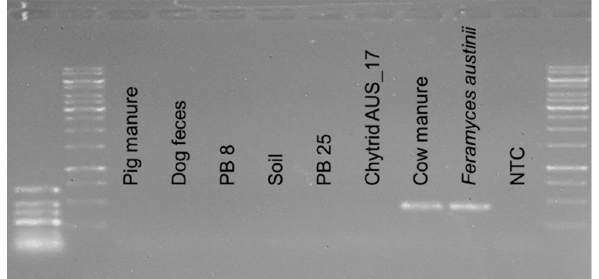
Figure 3. Agarose gel (1%) with amplicons of the D2 LSU subregion obtained from DNA extracts of different environmental samples (Table 2) generated with primer pair AGF-LSU-EnvS-Illumina. GeneRuler TM Low Range DNA Ladder (ThermoFisher) on the left, third and fourth bands 400 bp and 300 bp, respectively. GeneRuler TM 1 kb Ladder (ThermoFisher) on the right, second to last bar 500 bp and last bar 250 bp. DNA extracts of Feramyces austinii isolate DF1 and cow feces were used as positive controls. Further sample descriptions are listed in Table 2. NTC = no template